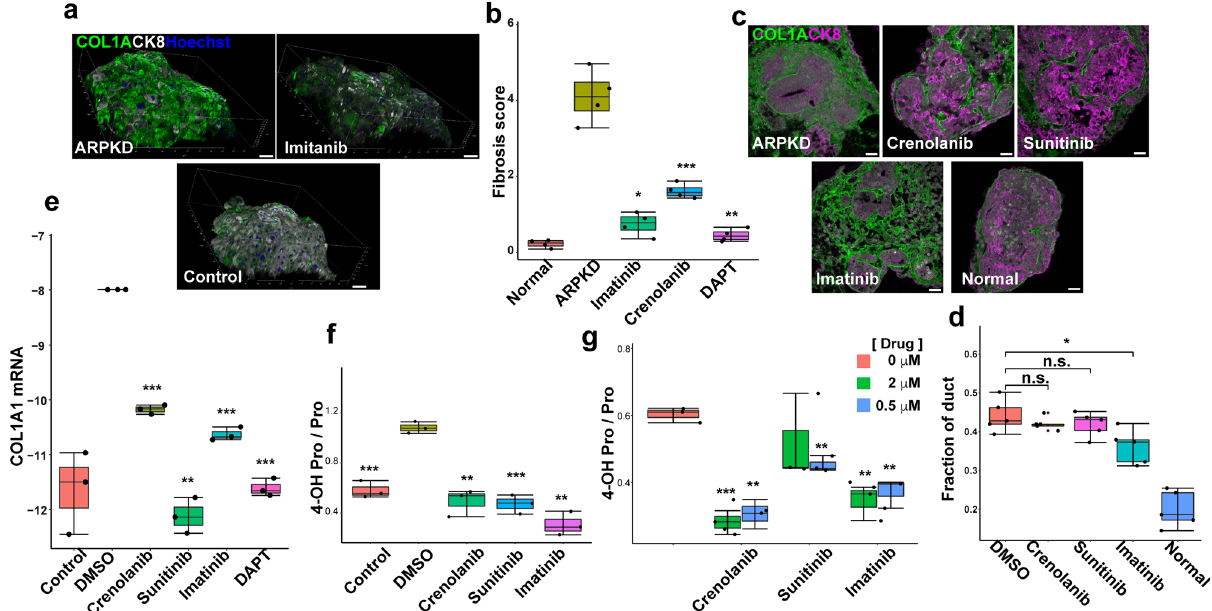
Fig. 7 PDGFR inhibitors reduce fi brosis in ARPKD organoids. Control or ARPKD organoid cultures were treated with vehicle or PDGFR inhibitors, and the extent of fi brosis developing in the cultures was measured by three different methods. a Whole-mount immunostaining of control HOs and of drug (10 μ M) or vehicle-treated ARPKD organoids. Representative images of organoids stained with COL1A and CK8 antibodies, and counterstained with Hoechst 33342. Scale bar, 50 μ m. b The fi brosis score was determined by measuring the ratio of the volume of COL1A and CK8 in 100 stacked images obtained from 4 whole-mount organoids per group. The PDGFR inhibitors (Crenolanib, Imatinib) decreased the fi brosis score in ARPKD organoids to levels that were similar to control organoids ( n = 4 per group, ARPKD vs Imatinib p = 0.00089, ARPKD vs Crenolanib p = 0.0042, ARPKD vs DAPT p = 0.0014). c Representative images of COL1A and CK8 immunostained ARPKD organoids before and after treatment with 10 μ M of the indicated inhibitor. For comparison, an image of an immunostained control organoid is also shown. Scale bar is 50 μ m. d The fraction of the total area occupied by bile ducts (CK8 + area) within isogenic control (normal) and ARPKD organoids after treatment with 10 μ M of the indicated drug ( n = 5 per group, DMSO vs Crenolanib p = 0.37, DMSO vs Sunitinib p = 0.58, DMSO vs Imatinib p = 0.015, n.s. no signi fi cant difference). e COL1A1 mRNA levels in ARPKD organoids are signi fi cantly higher than in control organoids, and were decreased 17-fold after treatment with the PDGFR inhibitors. RT-PCR measurements made on 3 organoids per treatment group; and the values were normalized relative to simultaneously measured GAPDH mRNA levels (DMSO vs Crenolanib p = 0.00048, DMSO vs Sunitinib p = 0.0021, DMSO vs Imatinib p = 0.00071, ARPKD vs DAPT p = 0.00068). Box plots in b , d , and e (center line, median; box limits, upper and lower quartiles; whiskers, 1.5 × interquartile range). Statistical differences between the groups were determined by